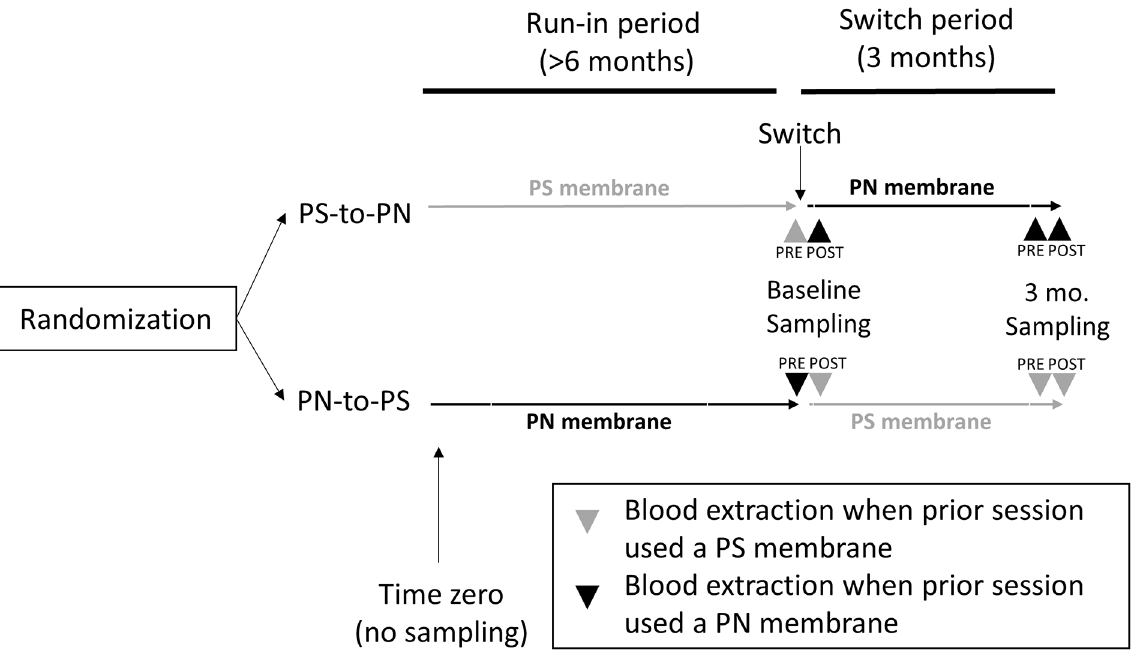
Fig 1. Study design: Timing of plasma sampling for BPA assessment. Baseline pre-dialysis plasma sampling took place after > 6 months OL-HDF and prior to the first session with the switch dialyzer. Baseline post-dialysis sampling was obtained immediately after the first session with the switch dialyzer. Sampling was repeated pre- and post-dialysis after 3 months on the switch dialyzer.